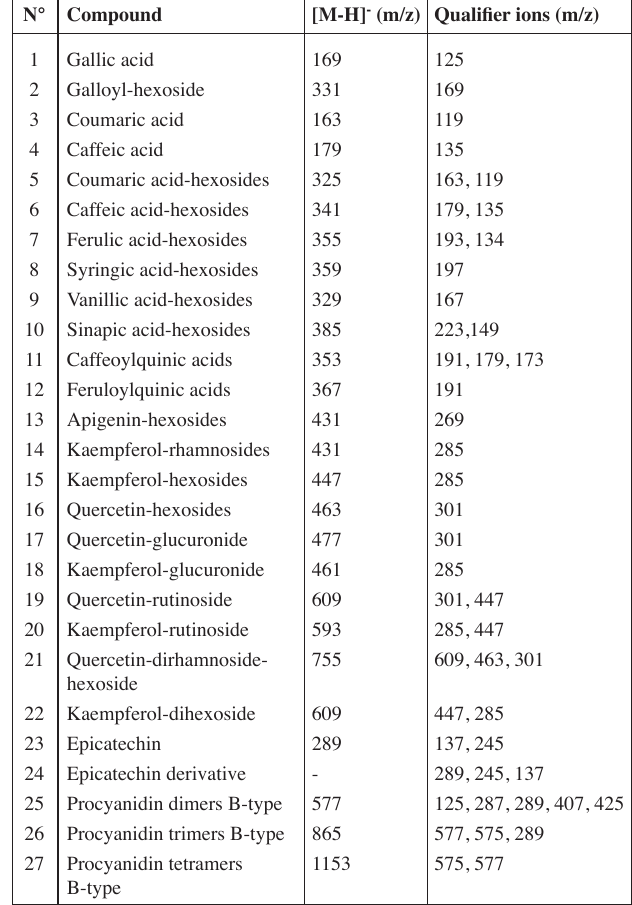
Tab. 2: Tentative identification of phenolic compounds based on their mass spectral